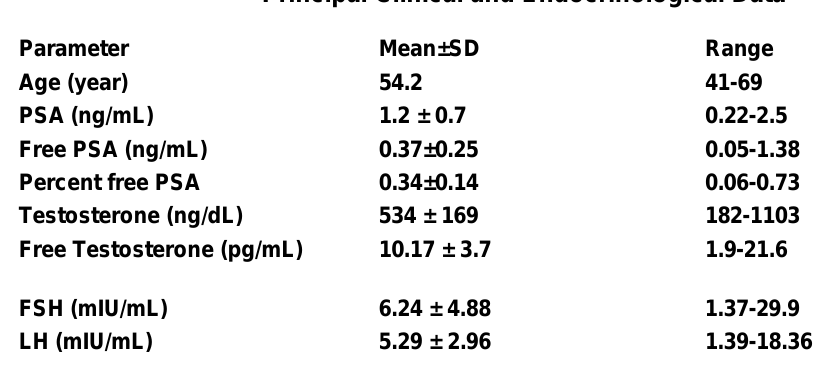
Principal Clinical and Endocrinological Data